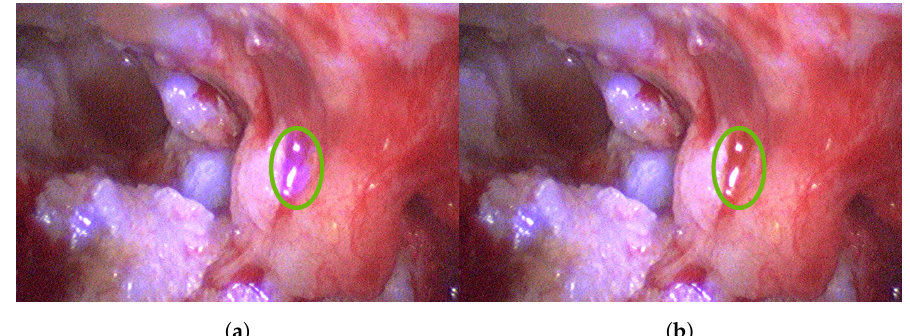
Figure 10. Importance of specular reflectance correction: ( a ) Enhanced RGB cholesteatoma visualization without specular correction showing wrongly detected regions. ( b ) Enhanced RGB cholesteatoma visualization with specular reflectance